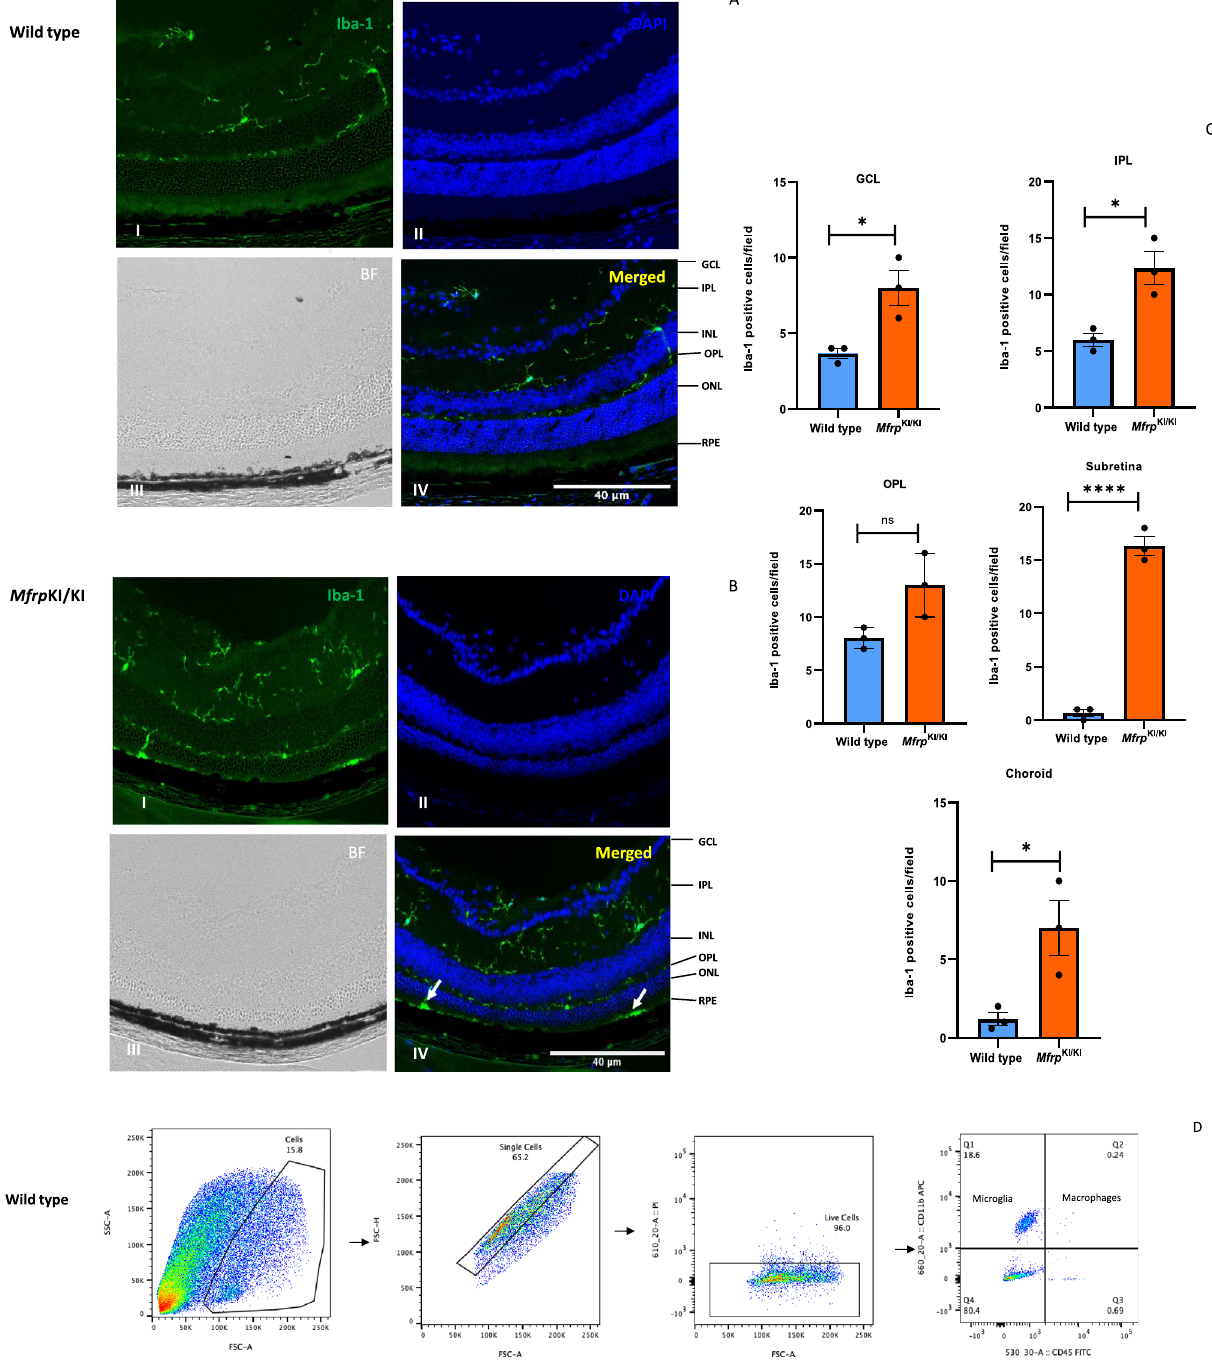
Figure 2. Immunostaining and flow cytometry for microglial and macrophage markers. ( A,B ) Retinal cryosections stained with Iba-1 antibody showed large numbers of positive cells in Mfrp KI/KI mice retina (I-Iba-1, II-DAPI, III-Brightfield (BF), IV-Merged) ( B ) particularly in the subretinal region (white arrows) compared with WT mice retinal cryosections (I-Iba-1, II-DAPI, III-Brightfield (BF), IV-Merged) ( A ). ( C ) Significantly higher numbers of microglia were present in Mfrp KI/KI mice retina when compared to WT mice retina in the subretina (**** p < 0.0001), GCL (* p < 0.05), IPL (* p < 0.05) and choroid (* p < 0.05) region (n = 3). ( D,E ) Flow cytometry of immune cells from mouse retina was performed. First, single cells were gated, followed by live cells. Microglia were gated as CD11b high CD45 low cells (Q1) and macrophages as CD11b high CD45 high (Q2). (F ,G ) There were significantly increased numbers of CD11b high CD45 low microglial cells (* p < 0.05) (n = 6) and monocyte-derived CD11b high CD45 high macrophages in Mfrp KI/KI retina compared with WT mouse retina (* p < 0.05) (n = 6) ( GCL ganglion cell layer, IPL inner plexiform layer, INL inner nuclear layer, OPL outer plexiform layer, ONL outer plexiform layer, RPE retinal pigment epithelial cell